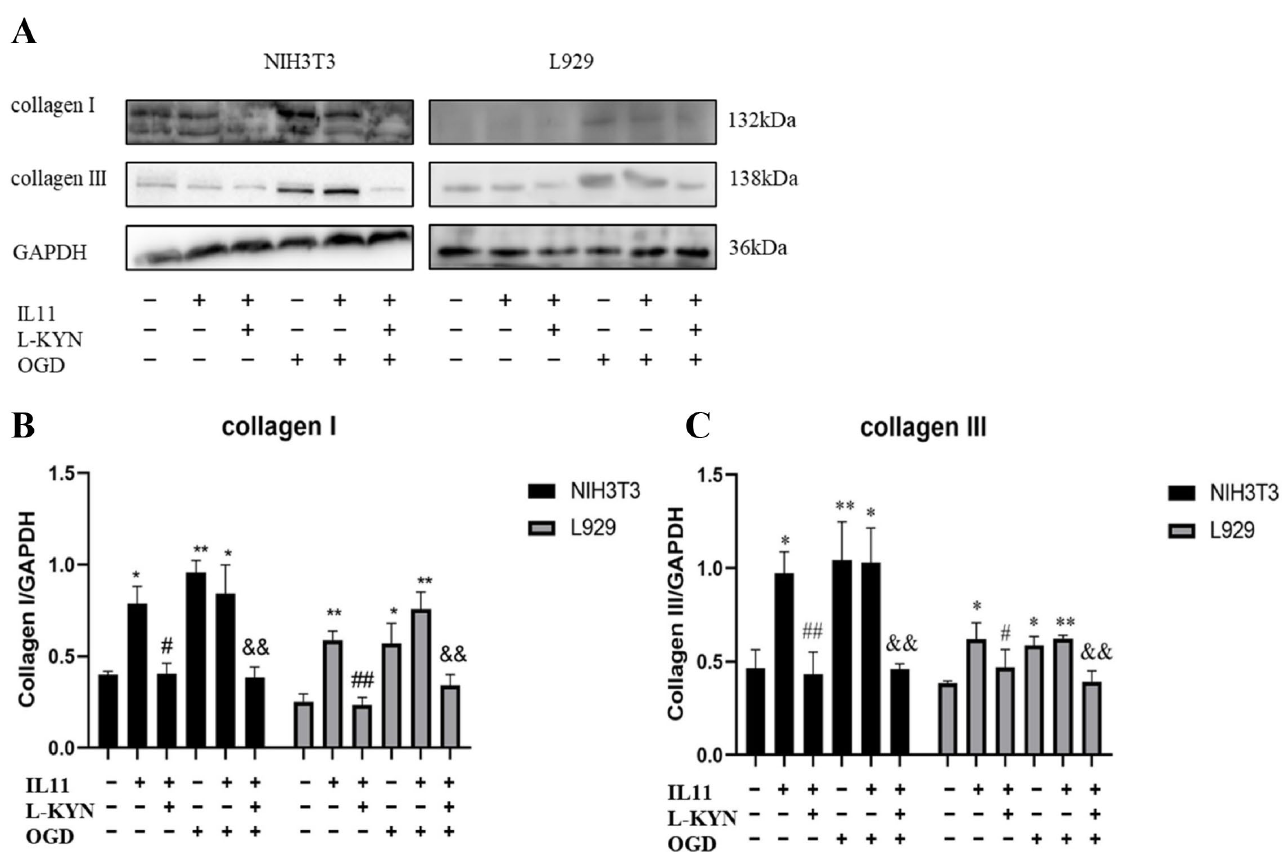
Figure 10. OGD inhibits the expression of IDO1/KYN in fibroblasts via IL11 . ( A ) Western blot analysis of collagen I and collagen III protein levels after supplementing 50 µ M KYN and 25 ng/mL rmIL11 in NIH3T3 and L929 cells. ( B ) Densitometric analysis of collagen I. ( C ) Densitometric analysis of collagen III. GAPDH was used as the loading control. OGD—oxygen–glucose deprivation; CON—control. The results are presented as the means ± SDs, and Student’s t -test was used to determine the p -value. * p < 0.5 and ** p < 0.01, compared with CON group; # p < 0.05 and ## p < 0.01, compared with IL11 group; && p < 0.01, compared with IL11 +OGD